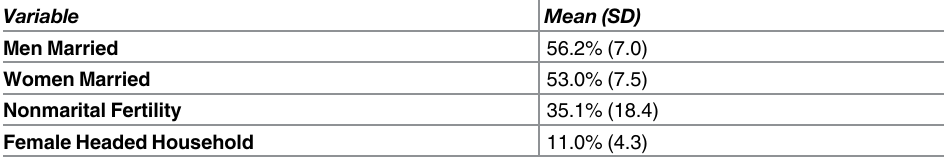
Table 2. Descriptive statistics for outcome variables in the study sample of 2,800 * counties in 50